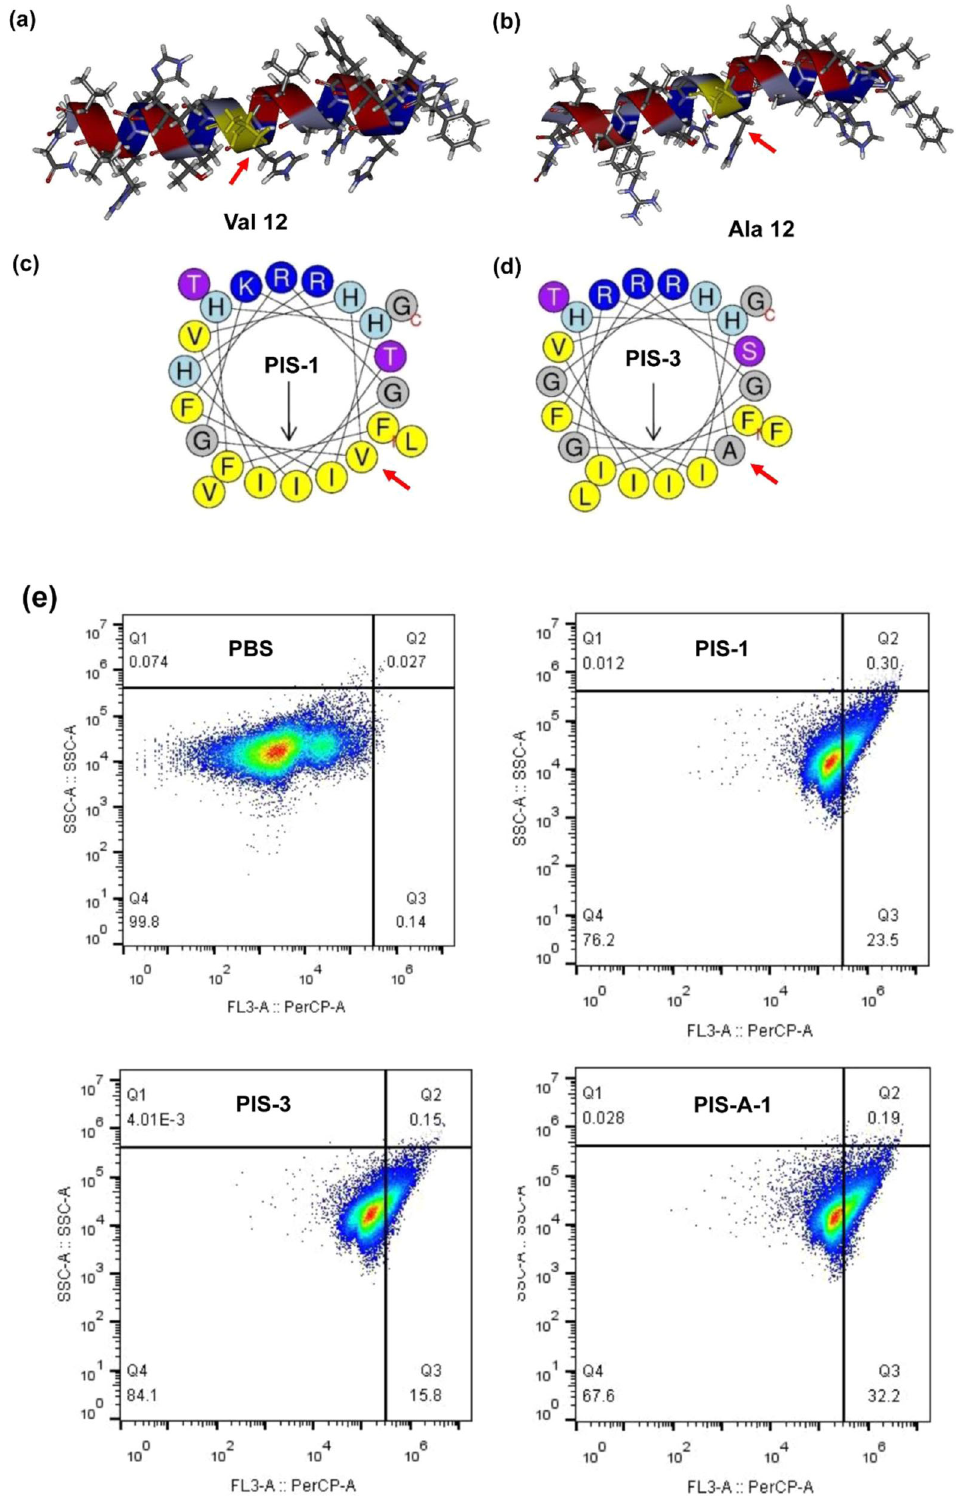
Fig. 2 Structural analysis of PIS-1 and PIS-3. a Solution NMR structure of PIS-1; a ribbon representation structure of lowest energy structure with side chains labeled (blue is hydrophilic and red is hydrophobic). b Solution NMR structure of PIS-3. c Helical wheel projection of PIS-1; amino acids in dark blue are positively charged, while in dark yellow are hydrophobic. d Helical wheel projection of PIS-3. e Flow cytometric